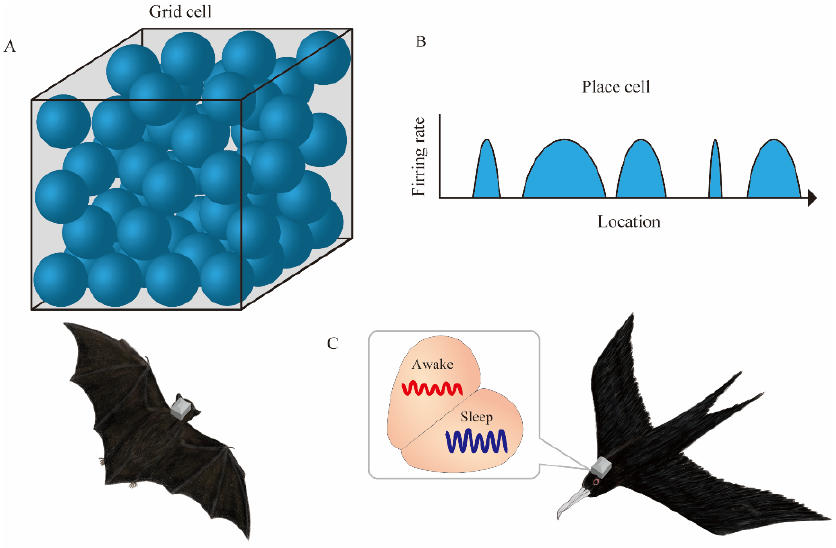
Figure 2. Neurologgers unveil the neural correlate of spatial cognition in 3D and large spaces. ( A ) In 3D space, place fields (blue spheres) of bat grid cells are arranged as if they were balls packed in a box. ( B ) A single place cell in the hippocampal CA1 of bats has multiple place fields (blue arcs) with variable sizes during the flight in a 200-m-long tunnel. ( C ) Electroencephalogram (EEG) in the hyperpallium of frigatebirds alternates between sleep states in each hemisphere.